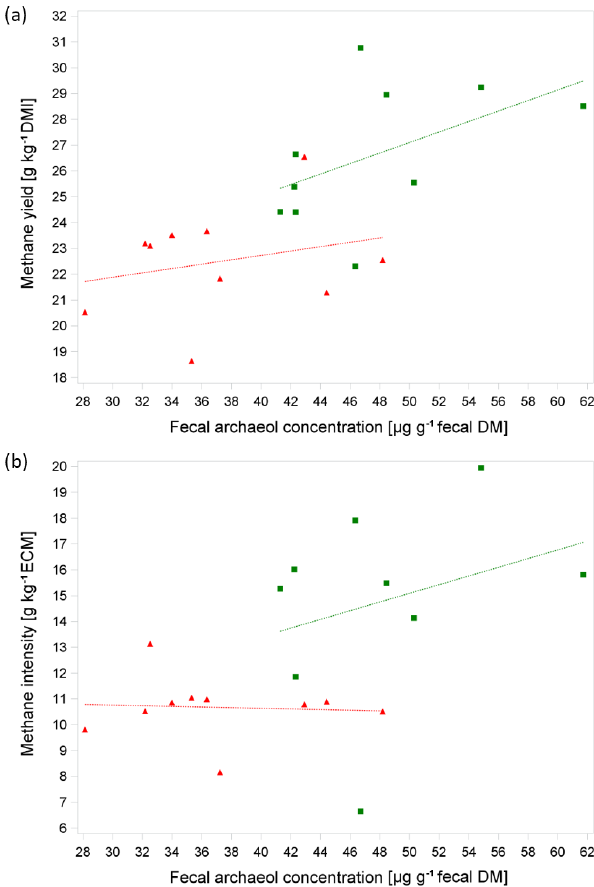
Figure 1. (a, b) Relationship between methane yield (in gkg − 1 DMI) or methane intensity (in gkg − 1 ) energy-corrected milk yield (ECM) and average fecal archaeol concentration from all three samples per cow (in µgg − 1 fecal DM) based on 10 cows in two con- secutive respiration chamber trials (trial 1: red triangle, diet with moderate starch and fat content at 100 ± 3d IM; trial 2: green box, diet with low starch and fat content at 135 ± 3d IM). Regression lines were not significantly